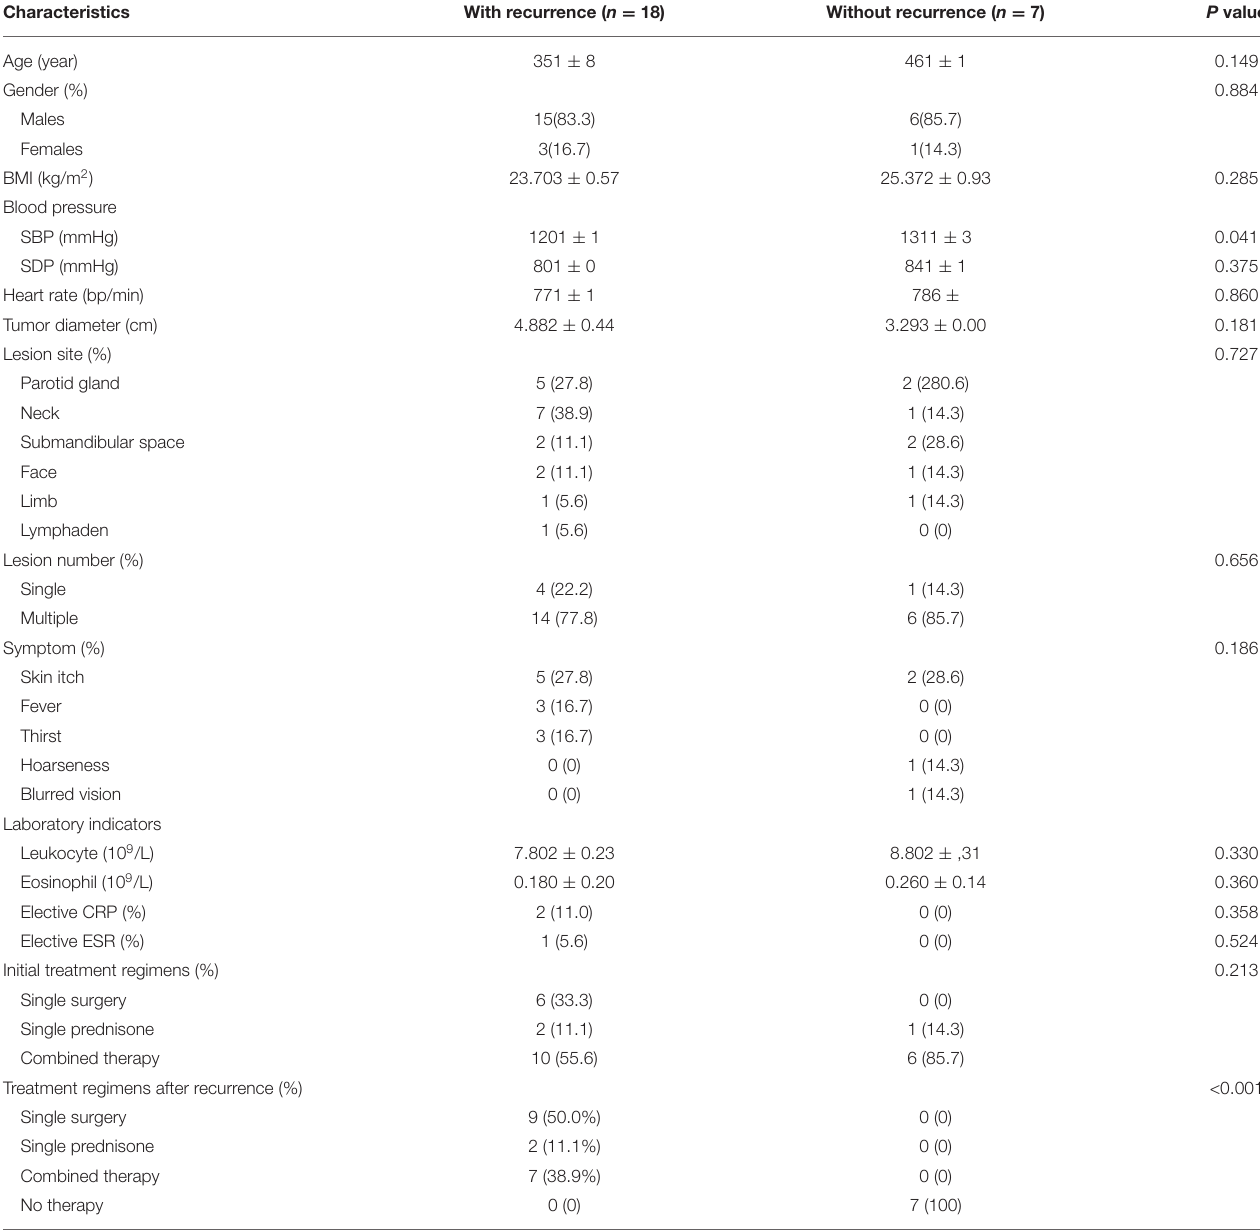
TABLE 3 | Characteristics of patients with Kimura disease with or without recurrence.